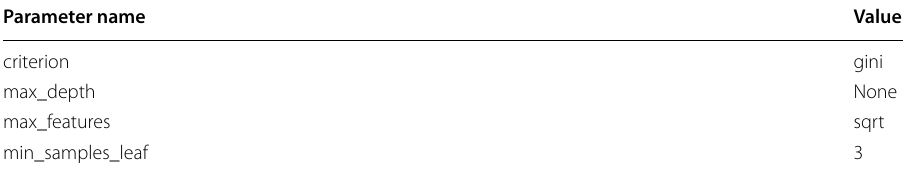
“None” value indicates default value of hyperparameter is optimal; parameter values for classifier yielding best results in terms of AUPRC